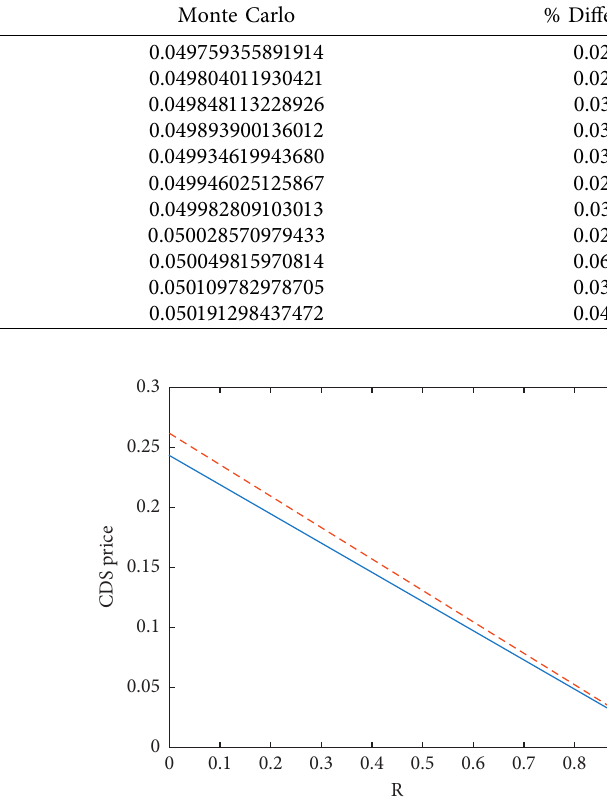
Figure 3: The CDS prices under different recovery